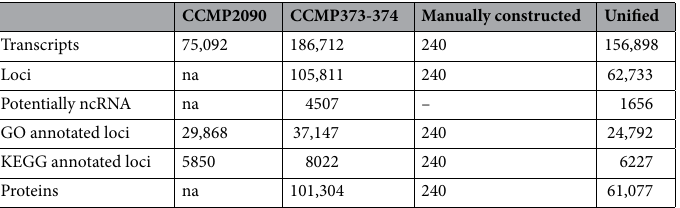
Table 1. Summary statistics of transcriptomes. Number of transcripts, loci, annotations per locus and proteins in the different transcriptomes. Na—not assessed.